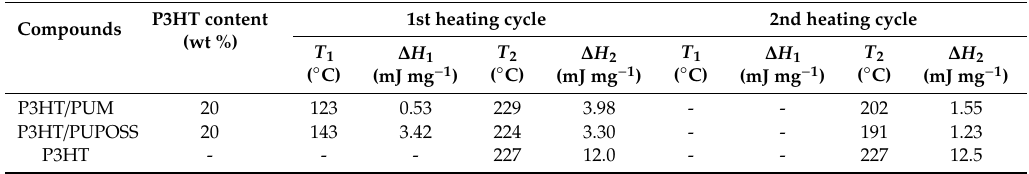
Table 2. Di ff erential scanning calorimetry data of the films.